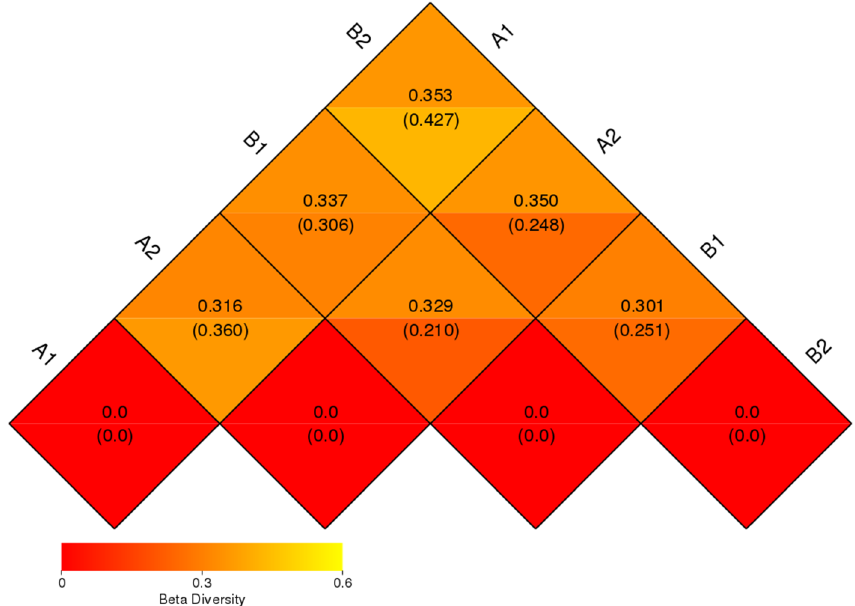
Figure 8. Beta diversity analysis of four compost stages (A1, thermophilic of Harmanli site; A2, mesophilic of Harmanli site; B1, mesophilic of Yasno pole site; B2, thermophilic of Yasno pole site).